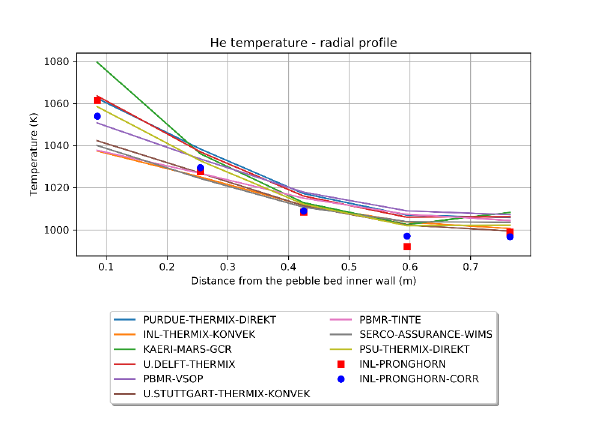
Figure 16: He Temperature - Radial Profile